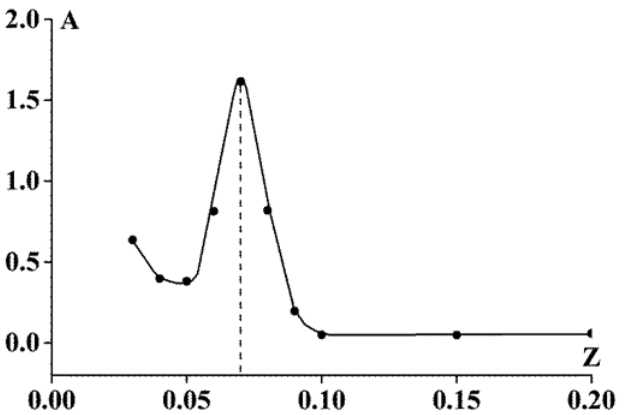
Figure 11. Optical density as a function of SA-gelatin mass ratio in the titration of gelatin sol (C G = 0.25%) with SA sol (C SA = 0.25%); λ = 400 nm, l = 1 cm, 23 °C.